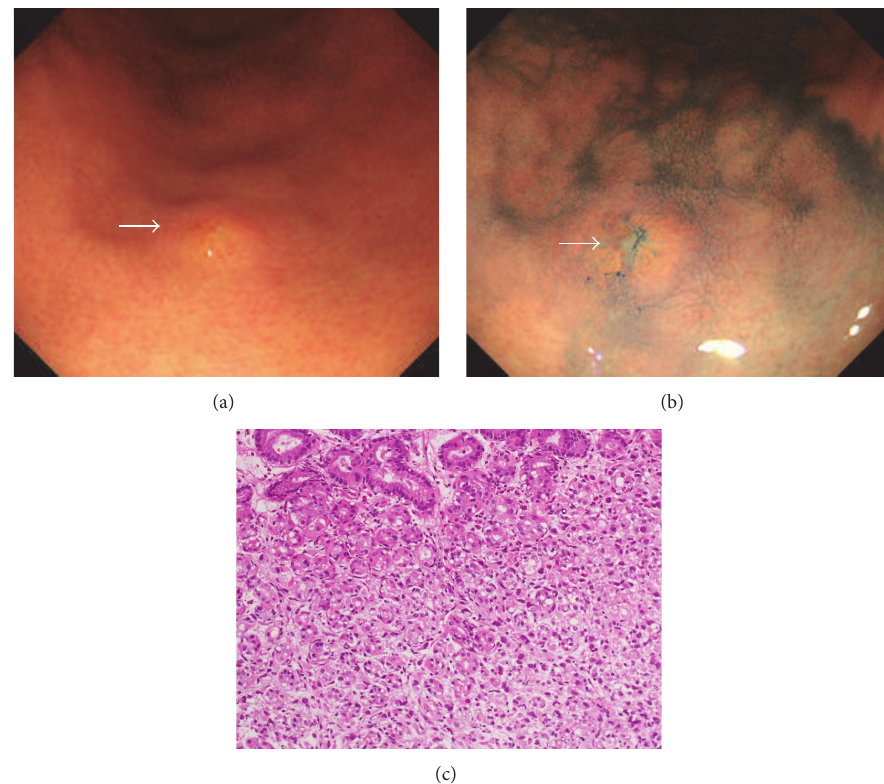
Figure 2: Esophagogastroduodenoscopy reveals a 0-IIc lesion with a size of 4 mm on the greater curvature of the gastric angle.